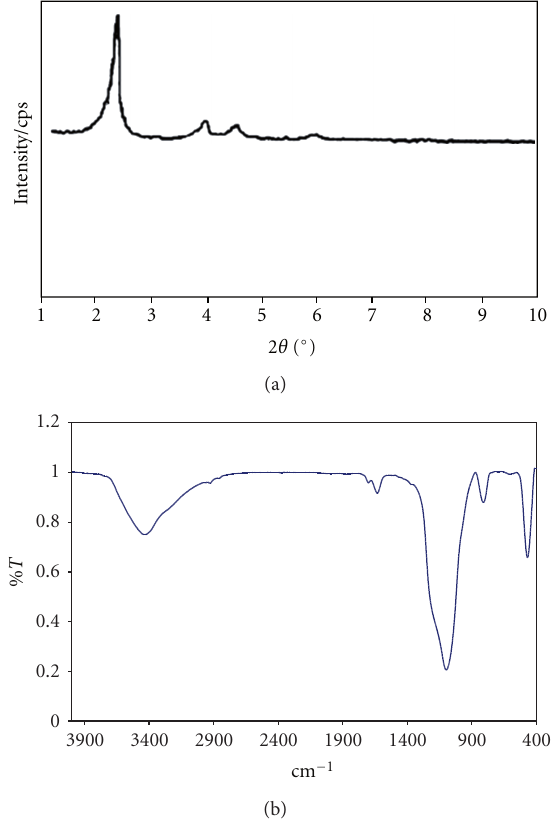
F 1: X-ray diffractogram and FTIR spectra of